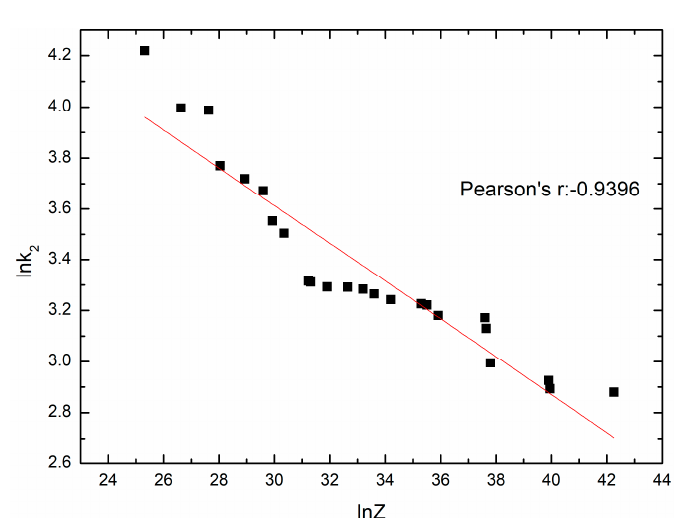
Figure 11. The relationship between and .